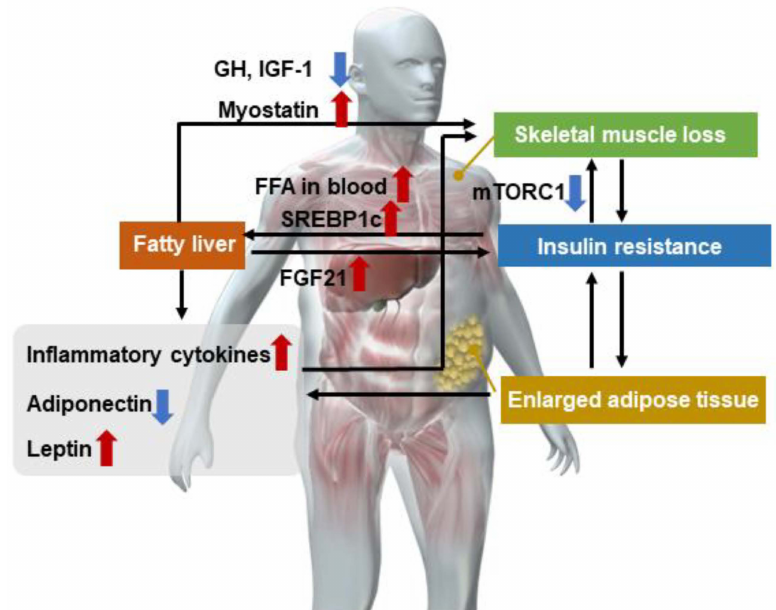
Figure 1. FFA, free fatty acid; FGF21, fibroblast growth factor 21; GF, growth factor; IGF-1, insulin-like growth factor: mTORC1, mechanistic/mammalian target of rapamycin complex 1; SREBP1c, Sterol regulatory element binding protein-1c. Upward arrows indicate enhancement and downward arrows indicate